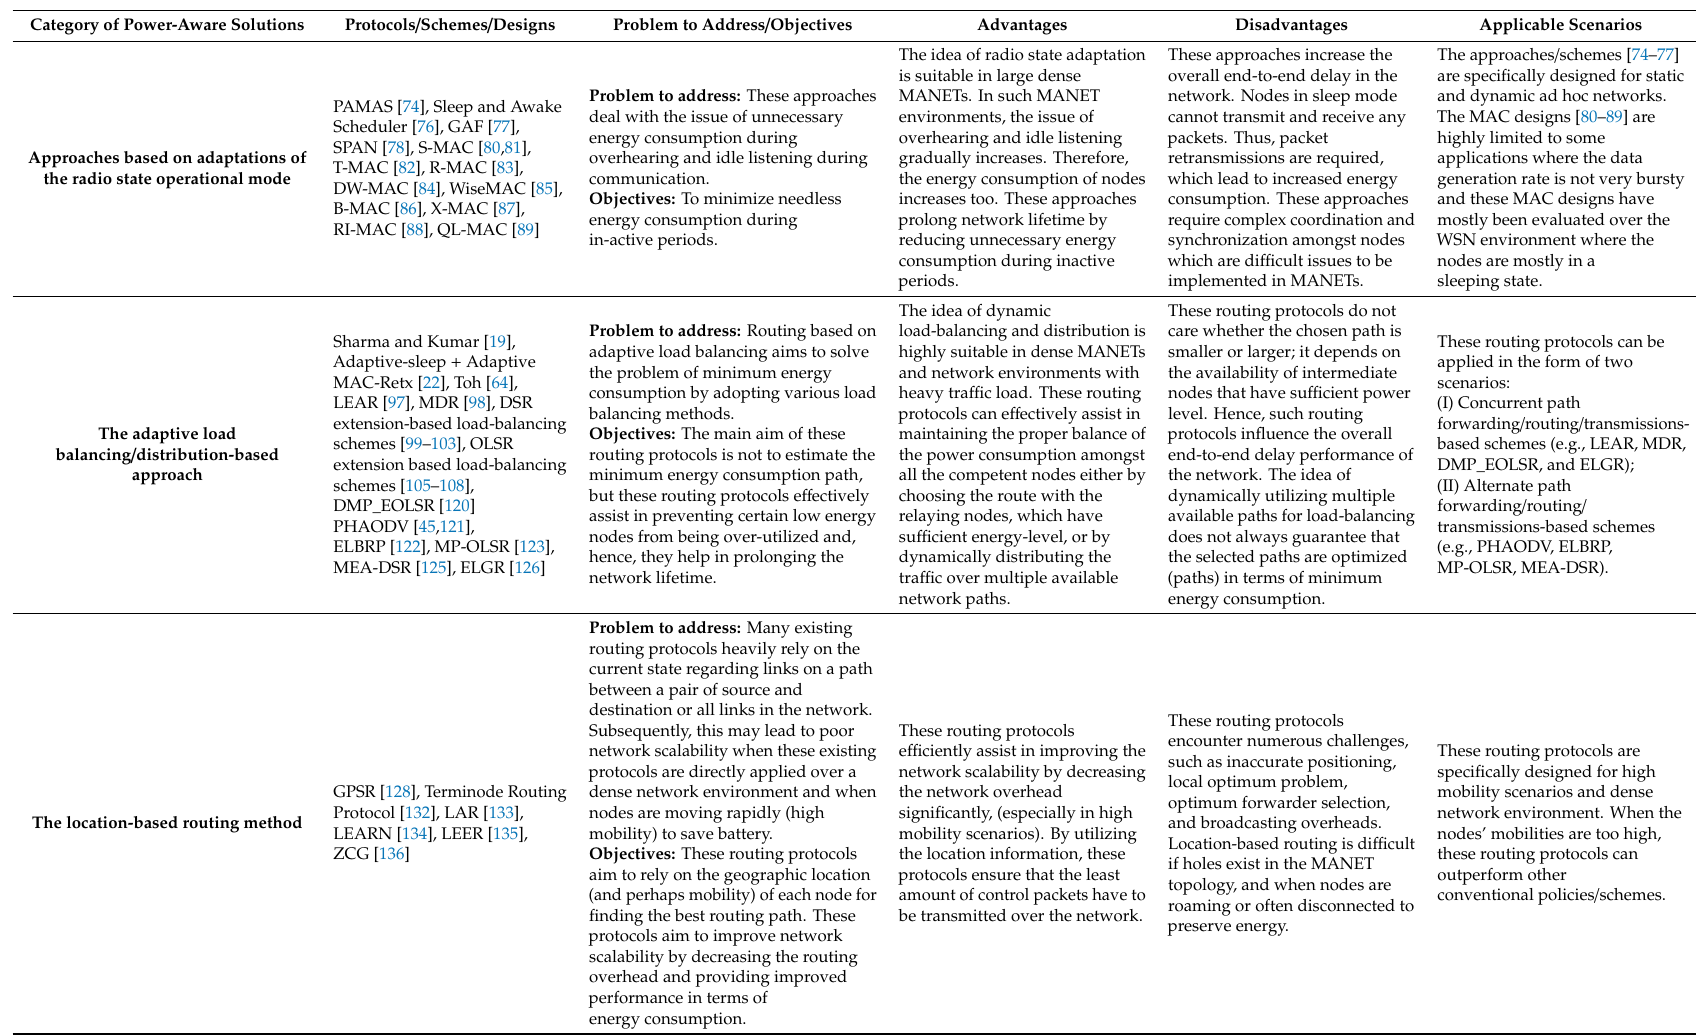
Table 4. A comparison of the categories of power-aware optimization solutions for